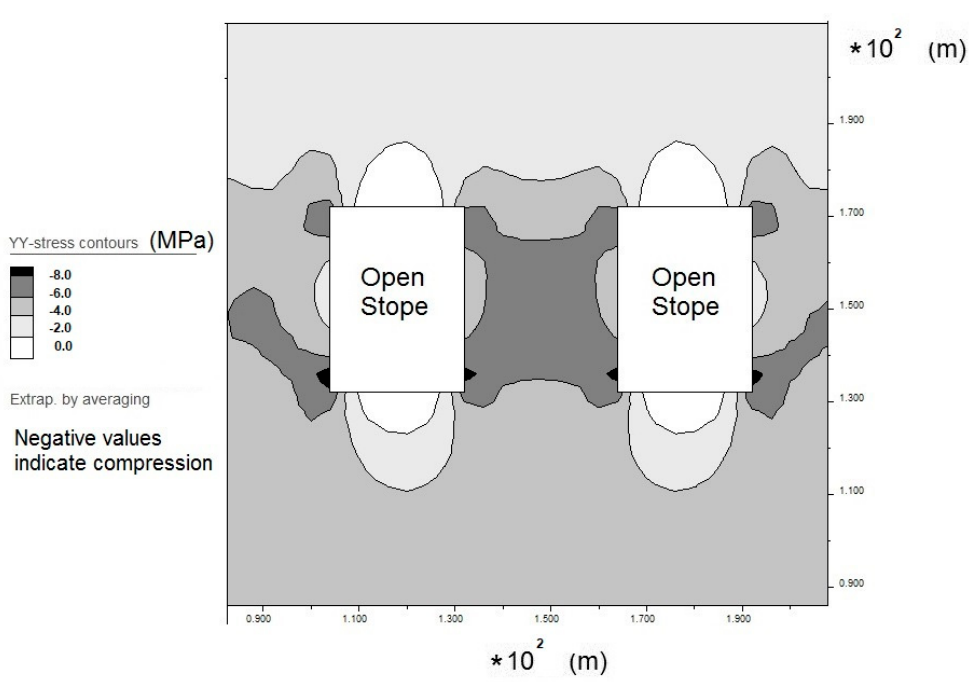
Figure 7. Vertical stresses between openings, W p = 32 m, H p = 40 m.